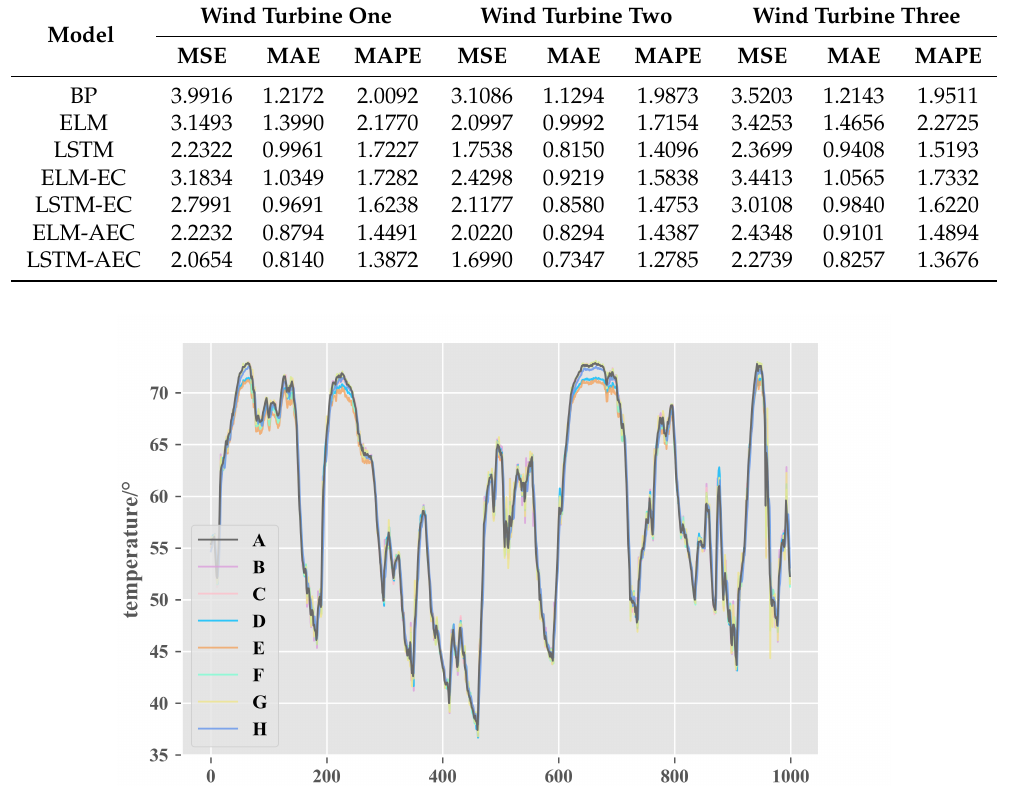
Table 4. Performance evaluations of different models for gearbox output shaft temperature prediction.